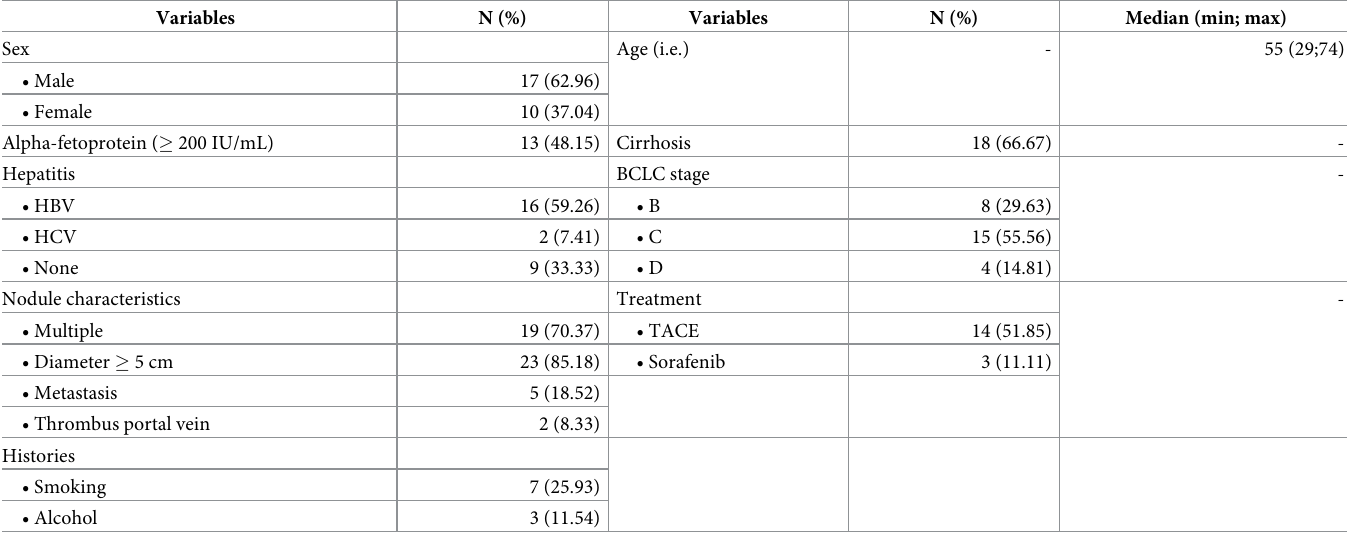
Table 2. The characteristic data for subjects with HCC (27 patients).